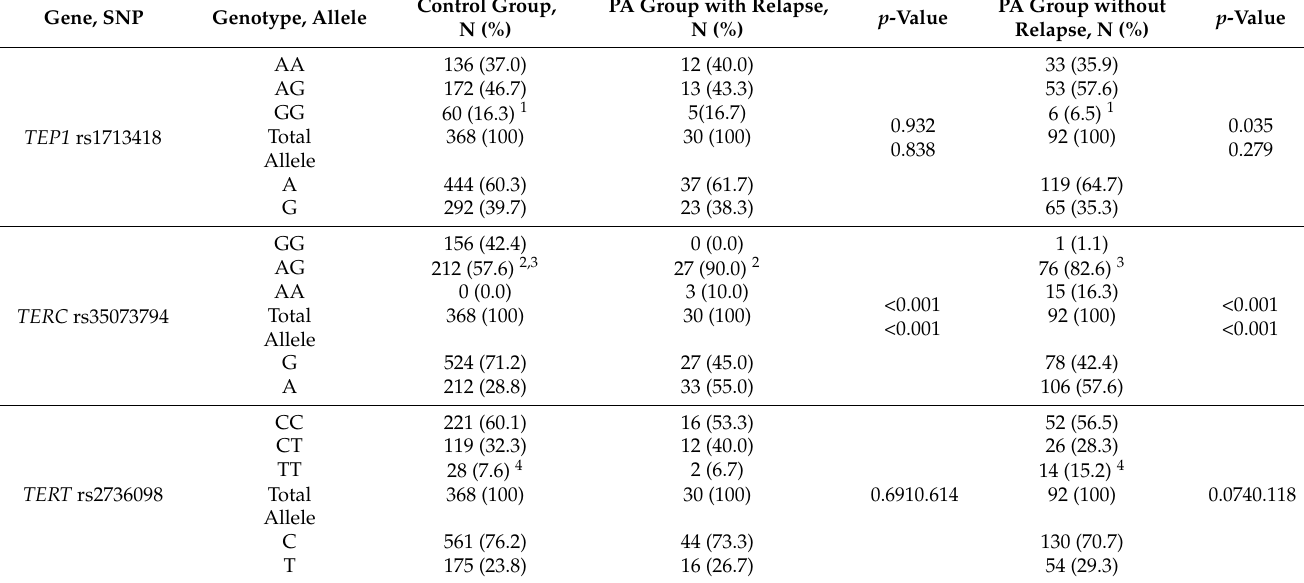
Table 8. TEP1 , TERC , and TERT genes single nucleotide polymorphisms frequencies of genotypes and alleles within pituitary adenoma with relapse or without relapse and control groups. Control Group, Gene, SNP Genotype, Allele N